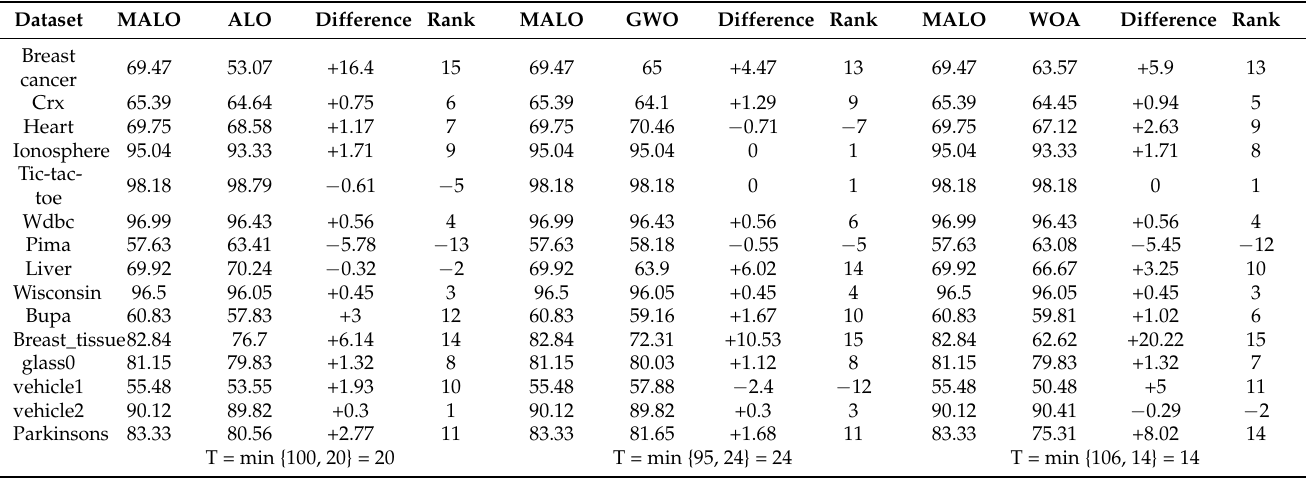
Table 11. Significance test of average accuracy between MALO vs. ALO, MALO vs. GWO, and MALO vs. WOA.